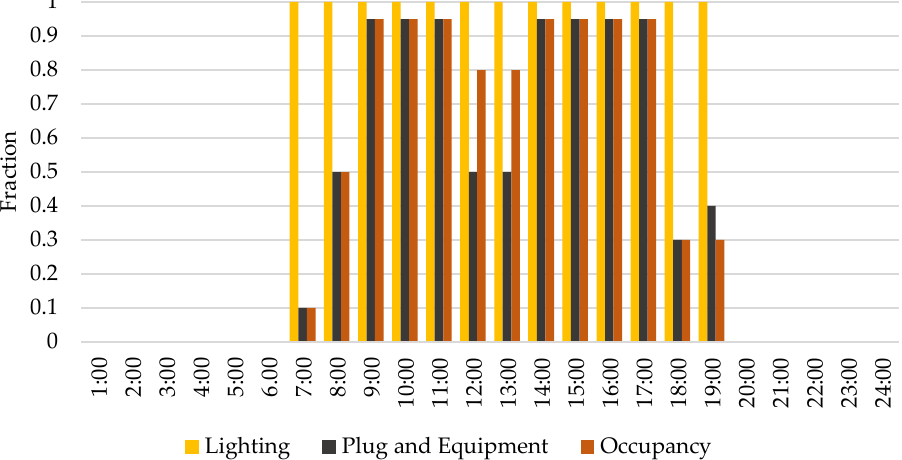
Lighting Lighting Plug and Equipment